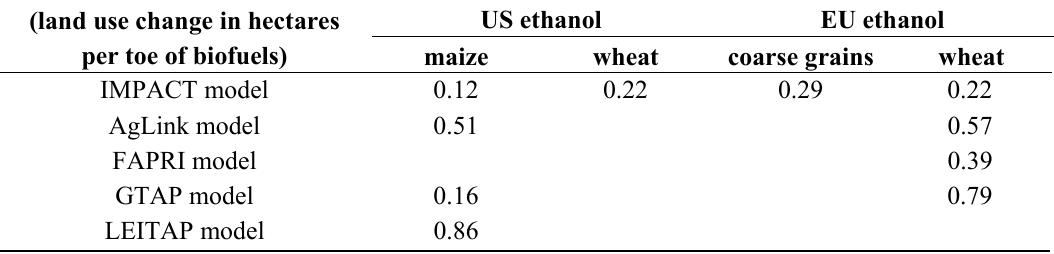
Table 5. Land use change effects in different